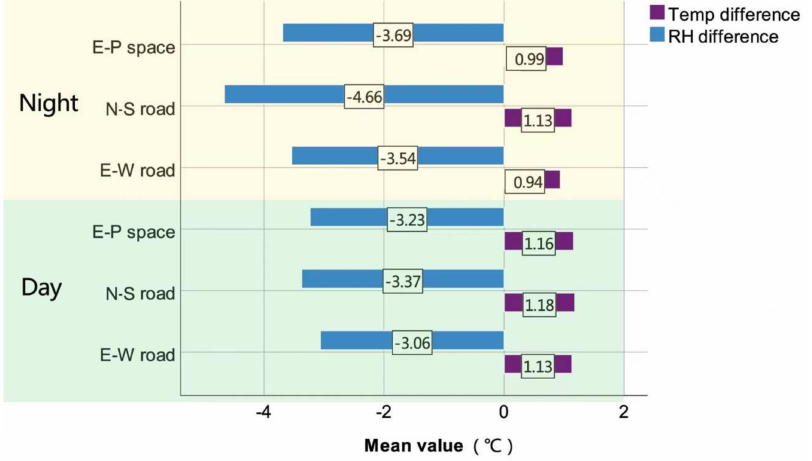
Figure 10. The difference values of air temperature (AT) and relative humidity (RH) with trees and with no trees.